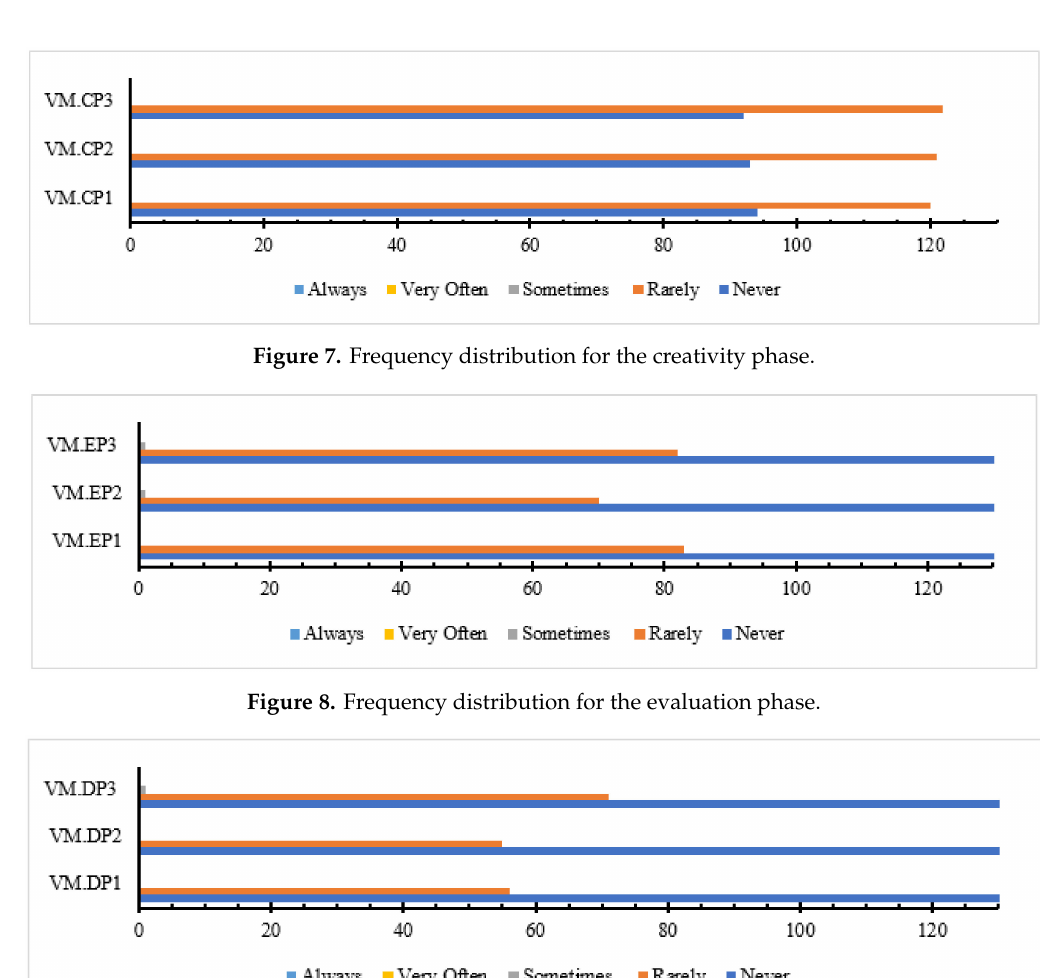
Figure 9. Frequency distribution for the development and presentation phases. Figure 6 indicates the distribution frequency of four (4) variables (VM.FP1–VM.FP4) in